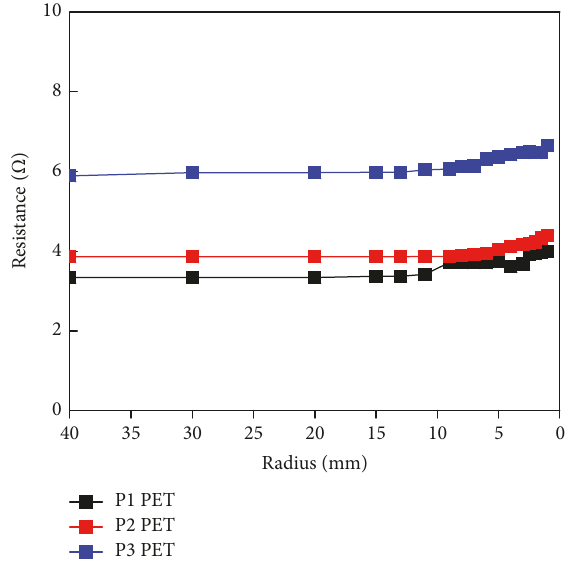
Figure 9: Electrical resistance versus radius of curvature plot for outer bending test.